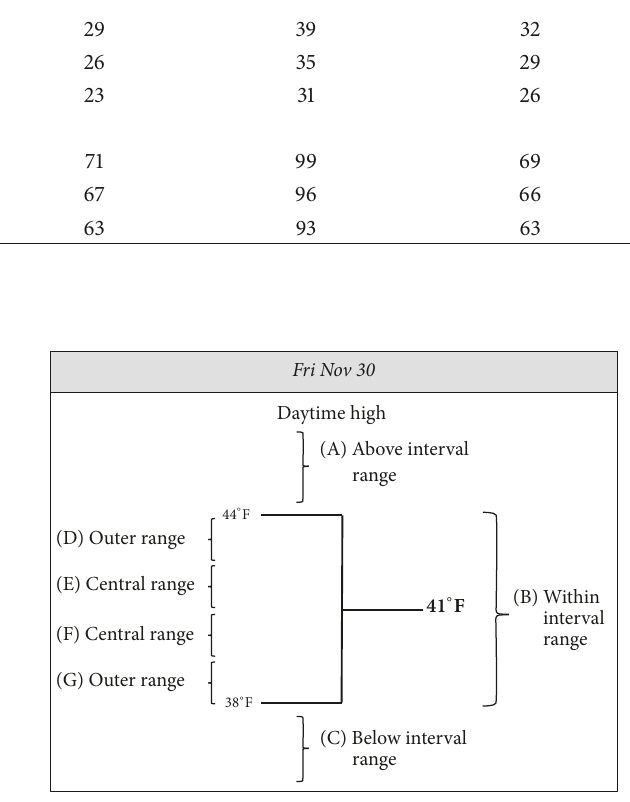
Figure 2: Ranges for which participants were asked to estimate the likelihood.Fontsizesareslightlysmallerinthisfigurethantheywere in the experiment to conform to journal